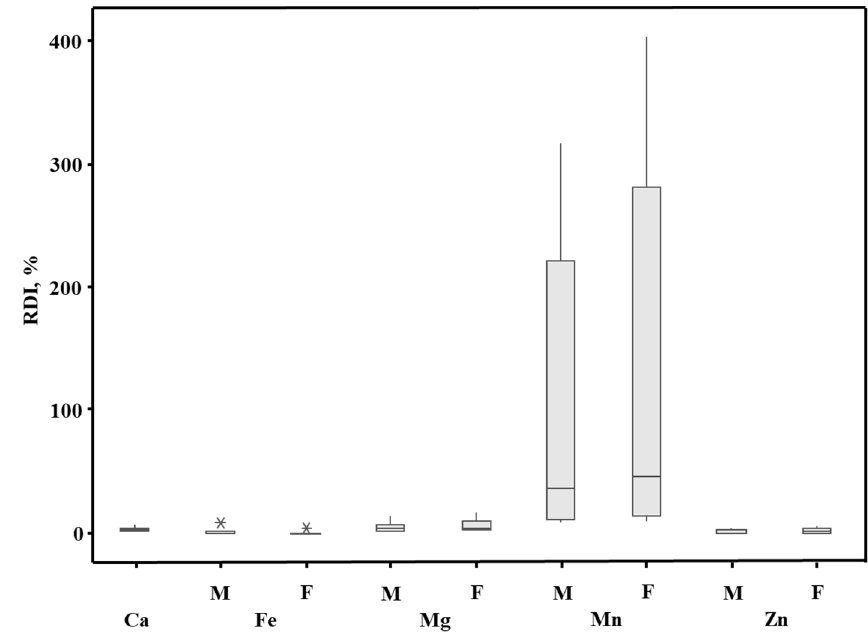
Figure 2. Box-and-whisker plots of the nutritional value (as %RDI) of the analyzed yerba mate (YM) energy drinks (means, medians, minimal and maximal values, in addition to the 1st and the 3rd quartiles). *—an unusually large or small observation.